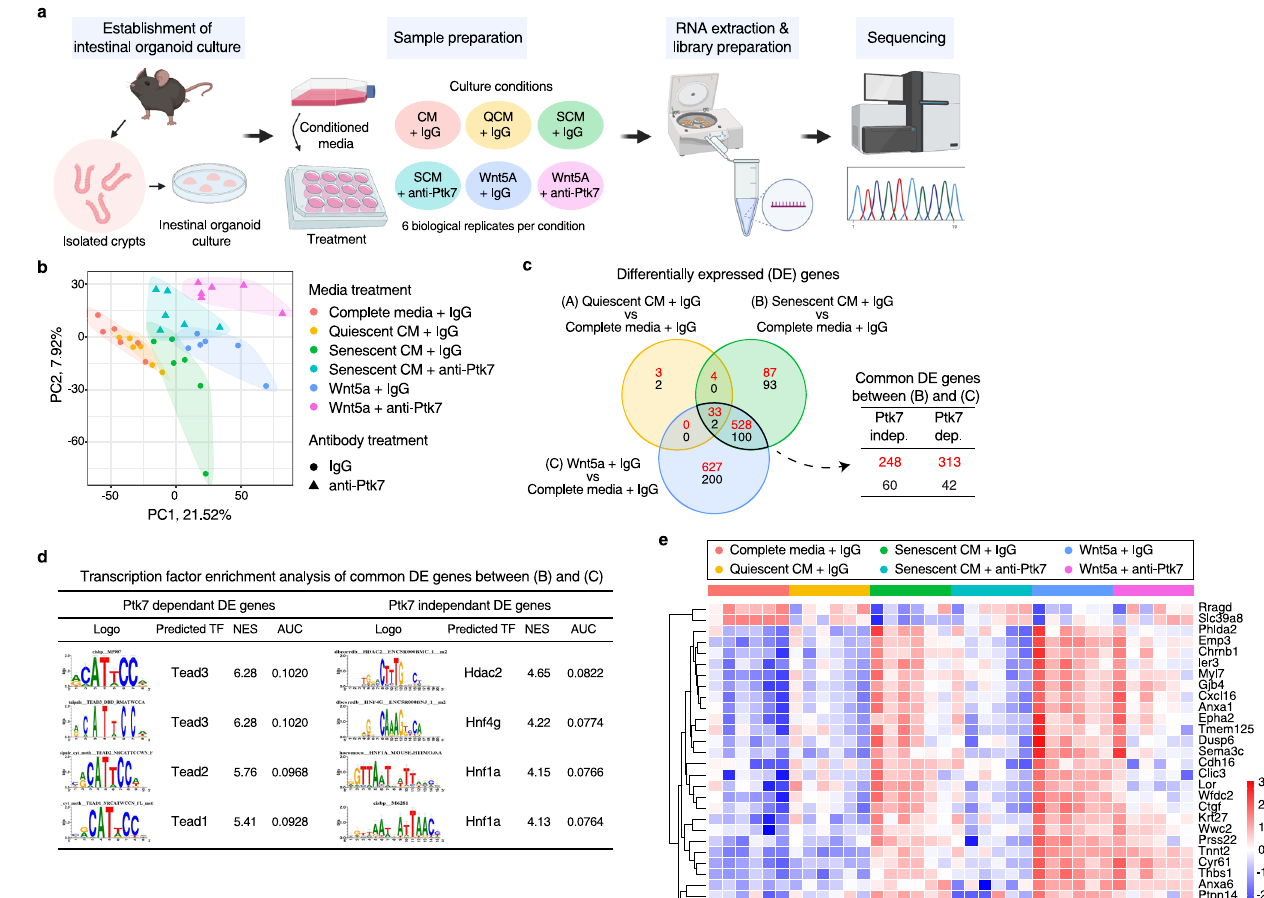
Fig.6|TranscriptomesoforganoidsshowsenrichmentofTEADbindingmotifs amongPtk7-dependentDEgenes.a Adiagramshowingthework fl owofintestinal organoid culture, media treatments, sample preparation, and RNAseq. The fi gure wascreated withBioRender.com. b Principalcomponent analysis(PCA)of RNAseq resultsfromtheindicatedorganoids.Eachpointrepresentsindividualsamples,and sample groups are indicated by using different colors as indicated in the legend provided. c Venndiagramshowingoverlapindifferentiallyexpressedgenes(DEGs) between the indicated conditions. Numbers of DEGs upregulated and down- regulatedareshowninredandblack,respectively.FDR<0.05andfoldchange>1.5